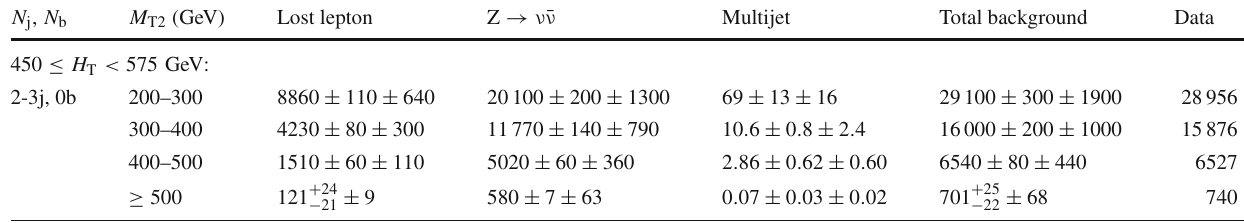
Table 14 Predictions and observations for the 28 search regions with tainty listed is statistical (from the limited size of data control samples 450 ≤ H T < 575 GeV, and 2 ≤ N j ≤ 3, 2 ≤ N j ≤ 6 and N b ≥ 3, or and Monte Carlo samples), and the second is systematic 4 ≤ N j ≤ 6. For each of the background predictions, the first uncer- N j , N b M T2 (GeV) Lost lepton Z → ν ¯ ν Multijet Total background